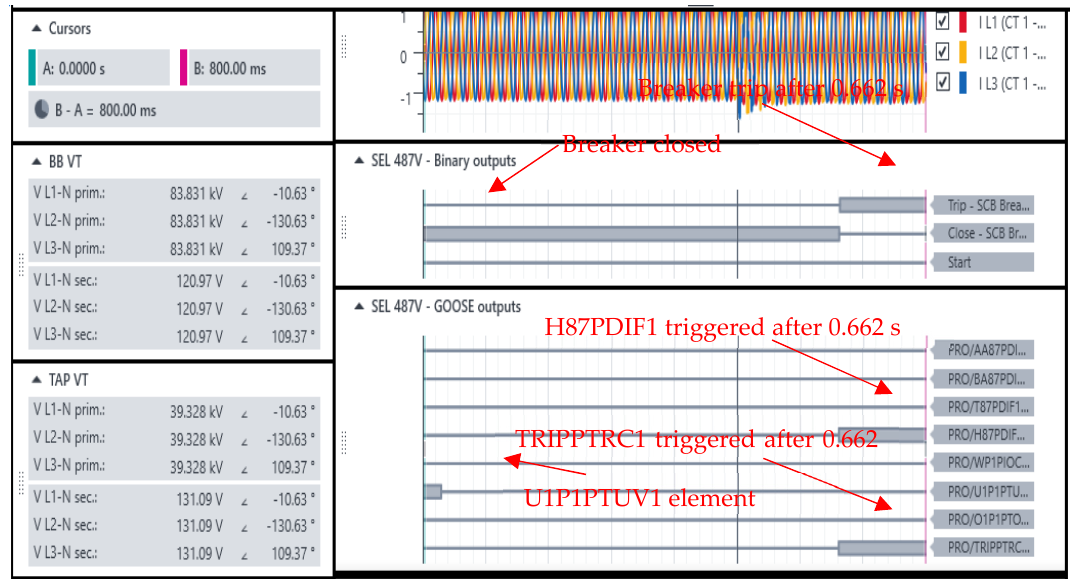
Figure 6. Simulation results for five elements failure below the